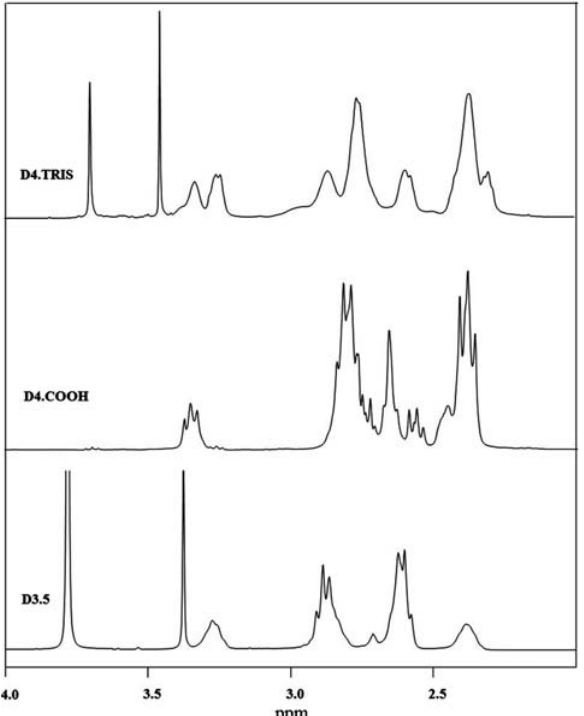
Figure 1. 1 H NMR spectrum monitoring of the conversion of D3.5 (bottom) to D4.COOH (middle) and D4.TRIS